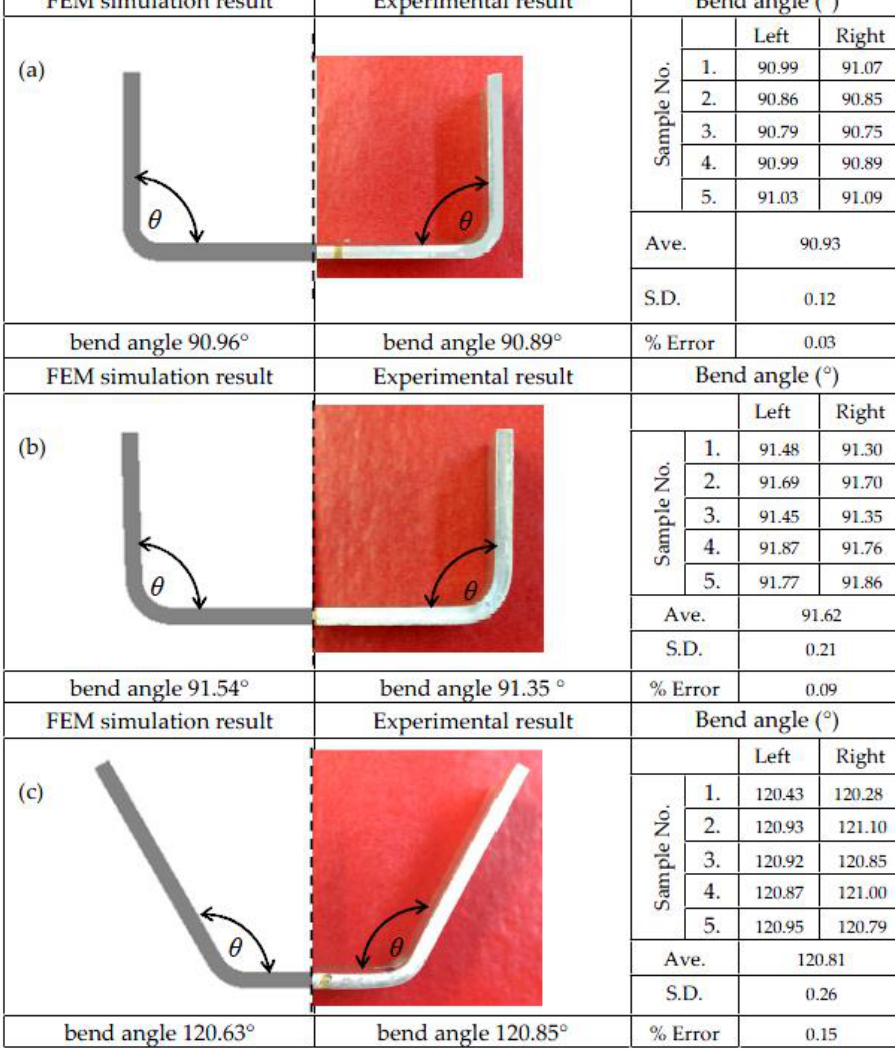
Figure 17. Comparison of the bent parts, obtained using FEM simulations and experiments: ( a ) without pressure pads ( θ : 90 ◦ , t : 3 mm, WP L : 130 mm, W : 60 mm, R p : 3 mm, R ud : 5 mm); ( b ) with pressure pads ( θ : 90 ◦ , t : 3 mm, WP L : 120 mm, W : 60 mm, R p : 5 mm, R ud : 5 mm); ( c ) with no pressure pads ( θ : 120 ◦ , t : 3 mm, WP L : 120 mm, W : 30 mm, R p : 5 mm, R ud : 5 mm). SD: Standard deviation.